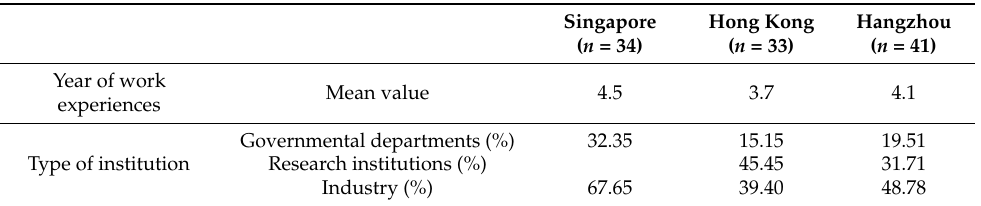
Table 5. Statistics of background information of the respondents in Singapore, Hong Kong and